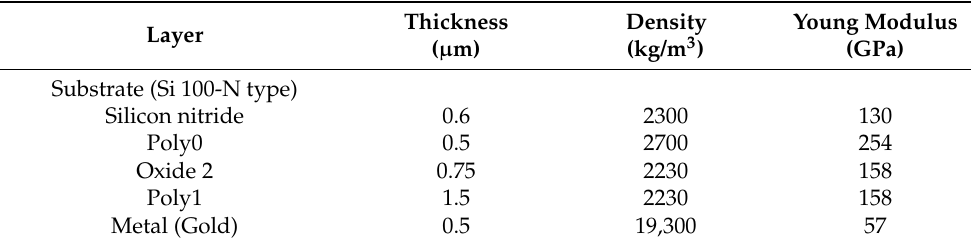
Table 3. Material layer properties utilized in the PolyMUMPs process are different [25].